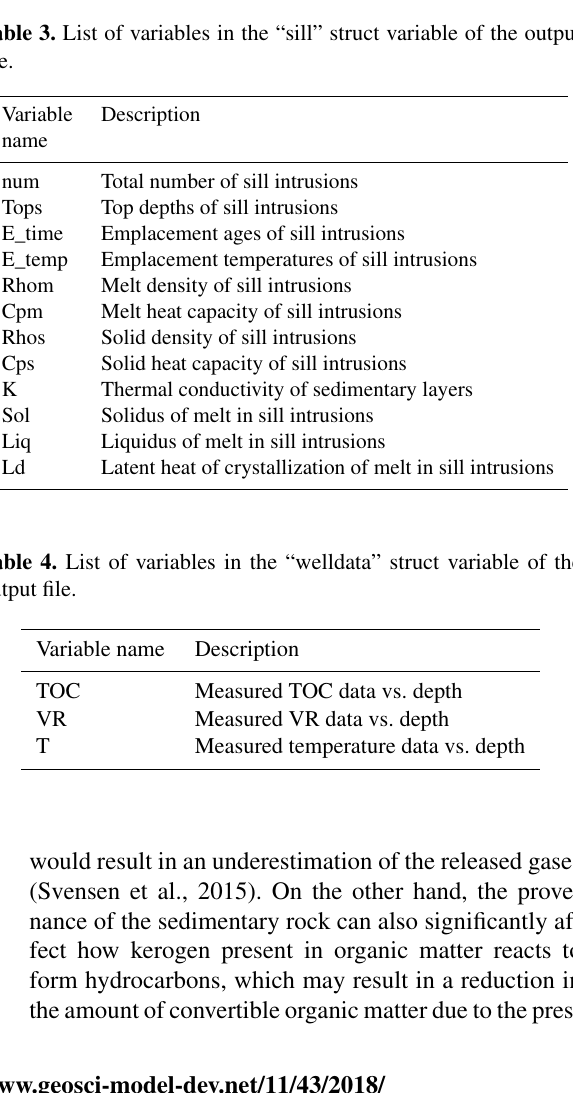
Top depths of the eroded layers only